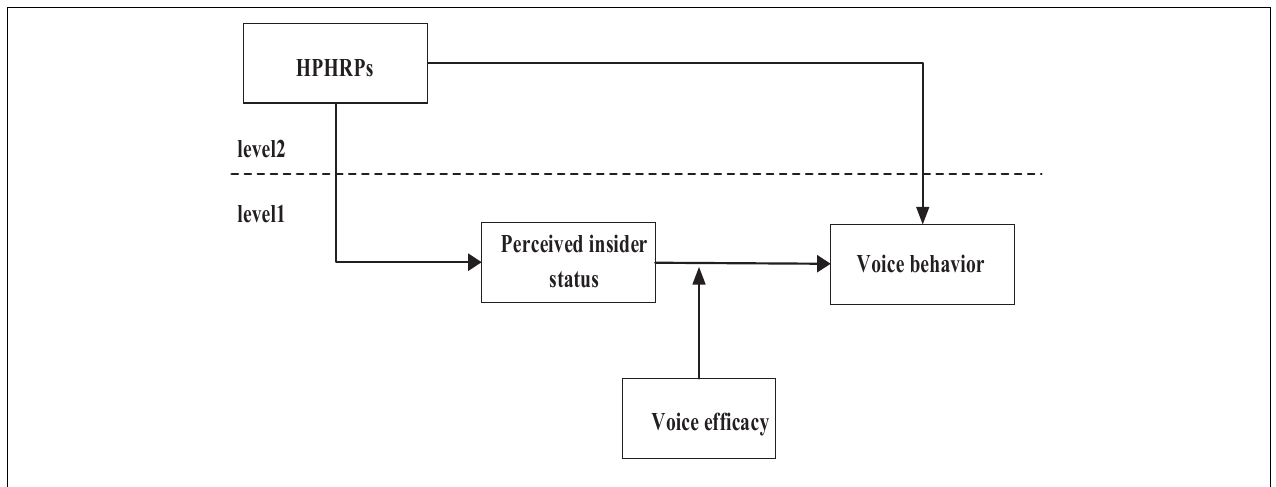
FIGURE 1 | Schematic of the research